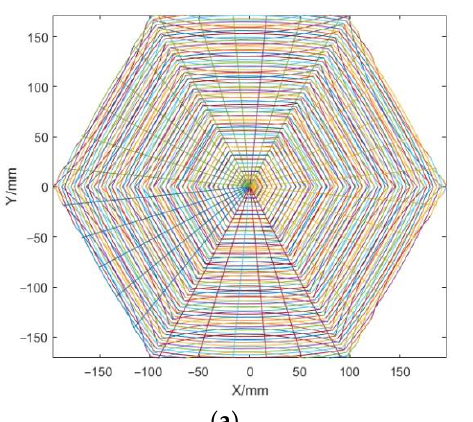
Figure 14. Projection of the workspace on the xoy plane: ( a ) Before optimization; ( b ) After optimization.